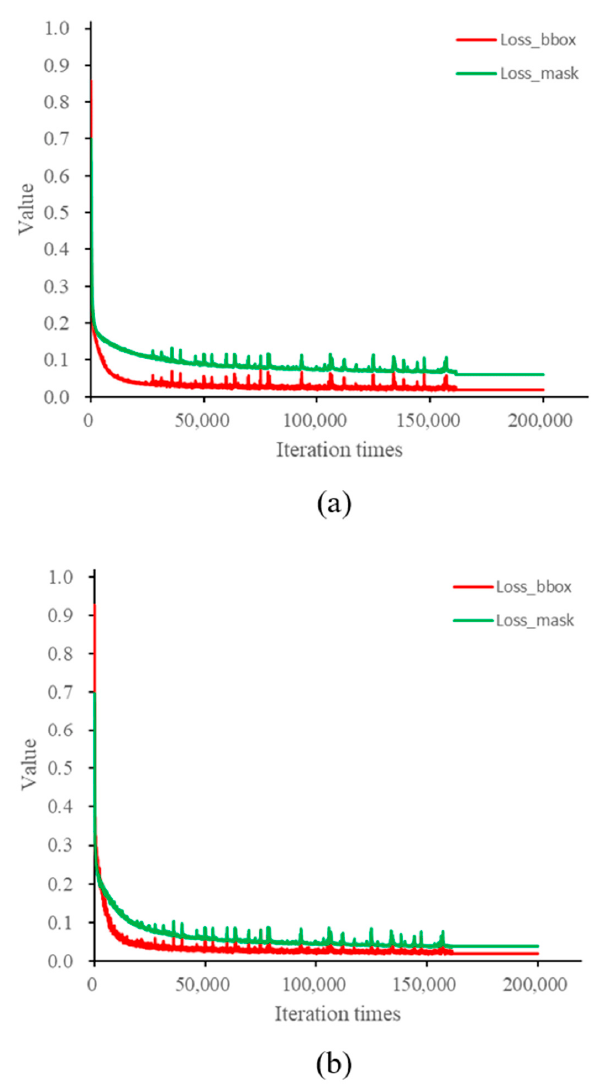
Figure 4. Training curves of loss values against iteration times on segmentation of ( a ) wheat spike and ( b ) diseased area.